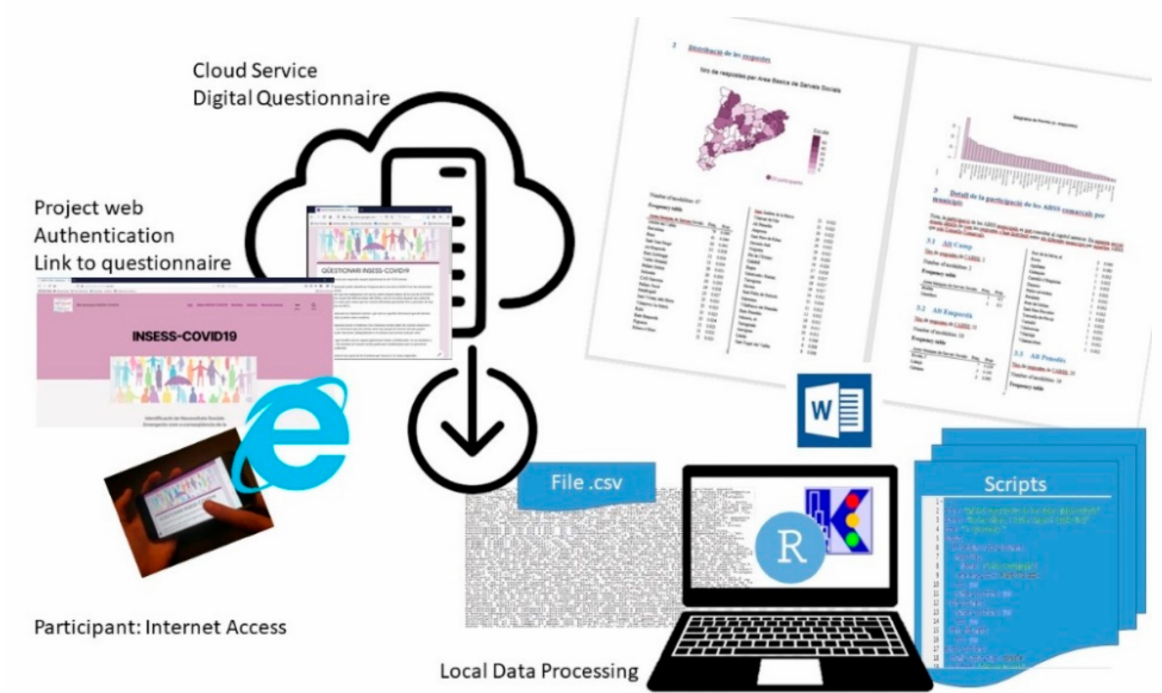
Figure 3. Technological infrastructure of INSESS-COVID19